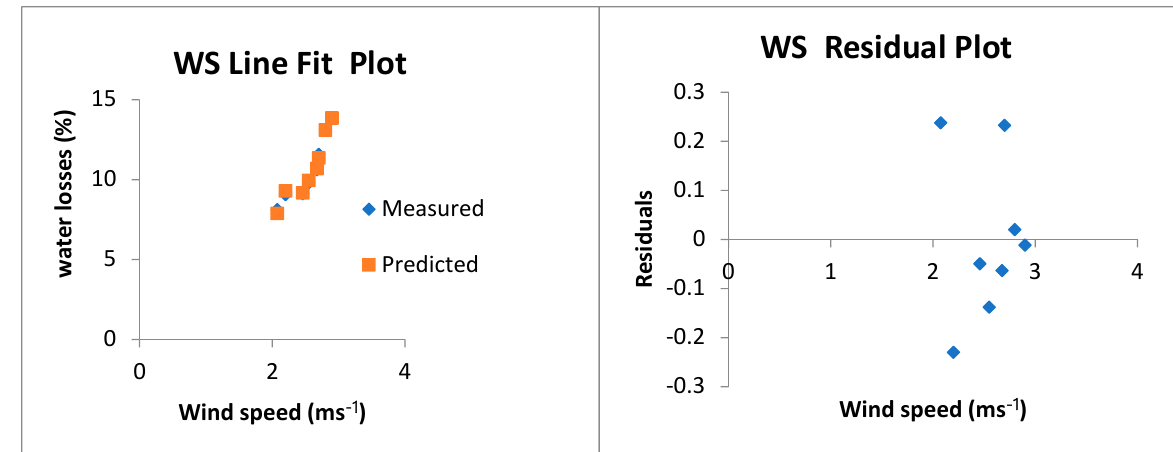
Figure 10. Measured and predicted water losses of the MLR model using the wind speed (WS) dataset.